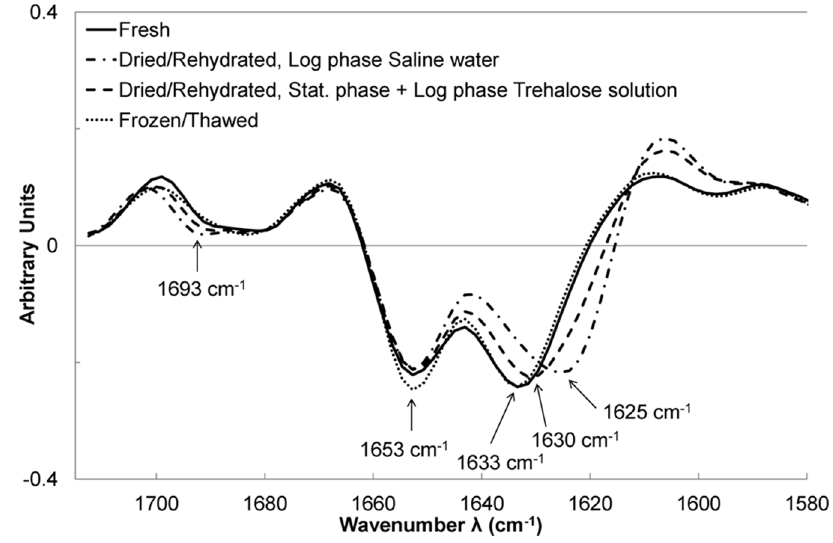
Figure 5. FT-IR analysis in the amide I region before and after stabilization treatments. Averaged second-order derivative and vector- normalized spectra in the 1715–1575 cm 2 1 region of all spectra obtained for freshly harvested cells (solid line) and further dried/rehydrated (dashed line) or frozen/thawed (dotted line). The specific behavior of dried/rehydrated cells after harvesting in the log phase and suspended in saline water (dashed-dotted line) can be observed (dashed